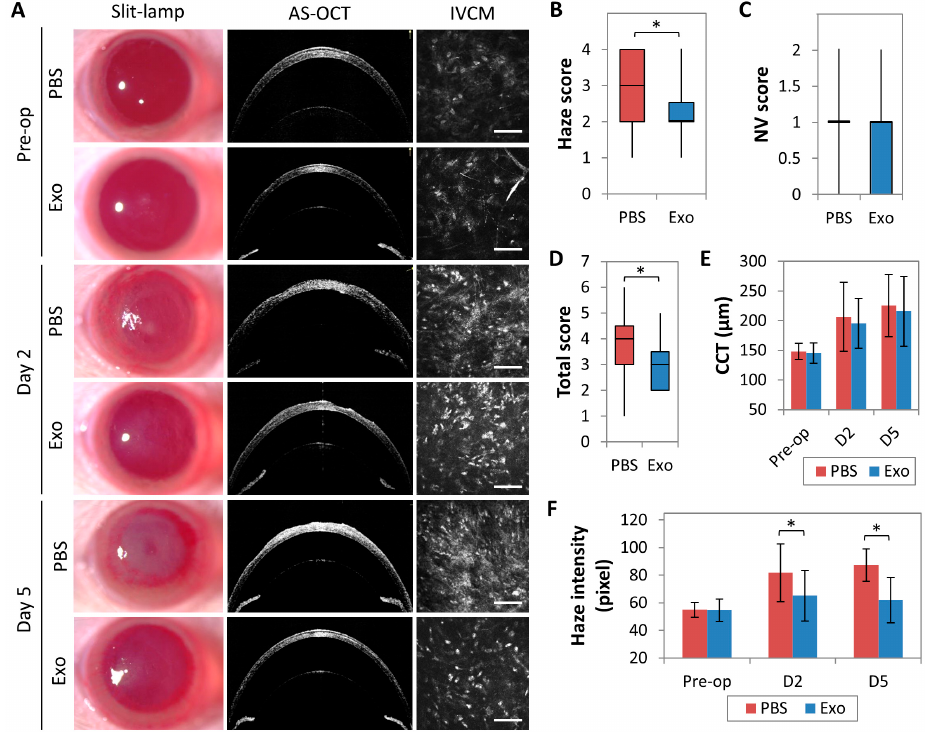
Figure 4. Evaluation of corneal stromal haze and corneal vascularization in eyes that had undergone irregular phototherapeutic keratectomy (irrPTK) with administration of topical mesenchymal stem cells-derived exosomes (MSC-exo) or phosphate-buffered saline (PBS). ( A ) Representative slit-lamp, anterior segment-optical coherence tomography (AS-OCT), and in vivo confocal microcopy images (IVCM) of rat corneas preoperatively and on days 2 (D2) and 5 (D5). Scale bars = 100 µm. Clinical grade scoring of corneas included a haze score (0–4, with 4 being the most severe opacification) ( B ), a neovascularization (NV) score (0–2, with 2 having vascularization >2 cm over the cornea) ( C ), and a total score (0–6, with 6 indicating the most severe opacification and neovascularization) ( D ). ( E ) Central corneal thickness (CCT) of the corneas preoperatively and at D2 and D5 postoperatively, measured from the AS-OCT images. ( F ) Comparative relative haze intensity at 10–15 µ m-stromal depth quantified by stromal reflectivity using IVCM, showing a significantly lower haze intensity in the group receiving MSC-exo compared to the control. * p <